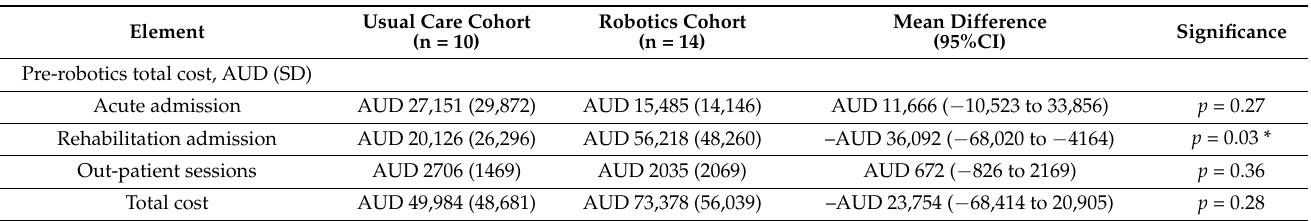
Table 7. Baseline health service and out-patient therapy